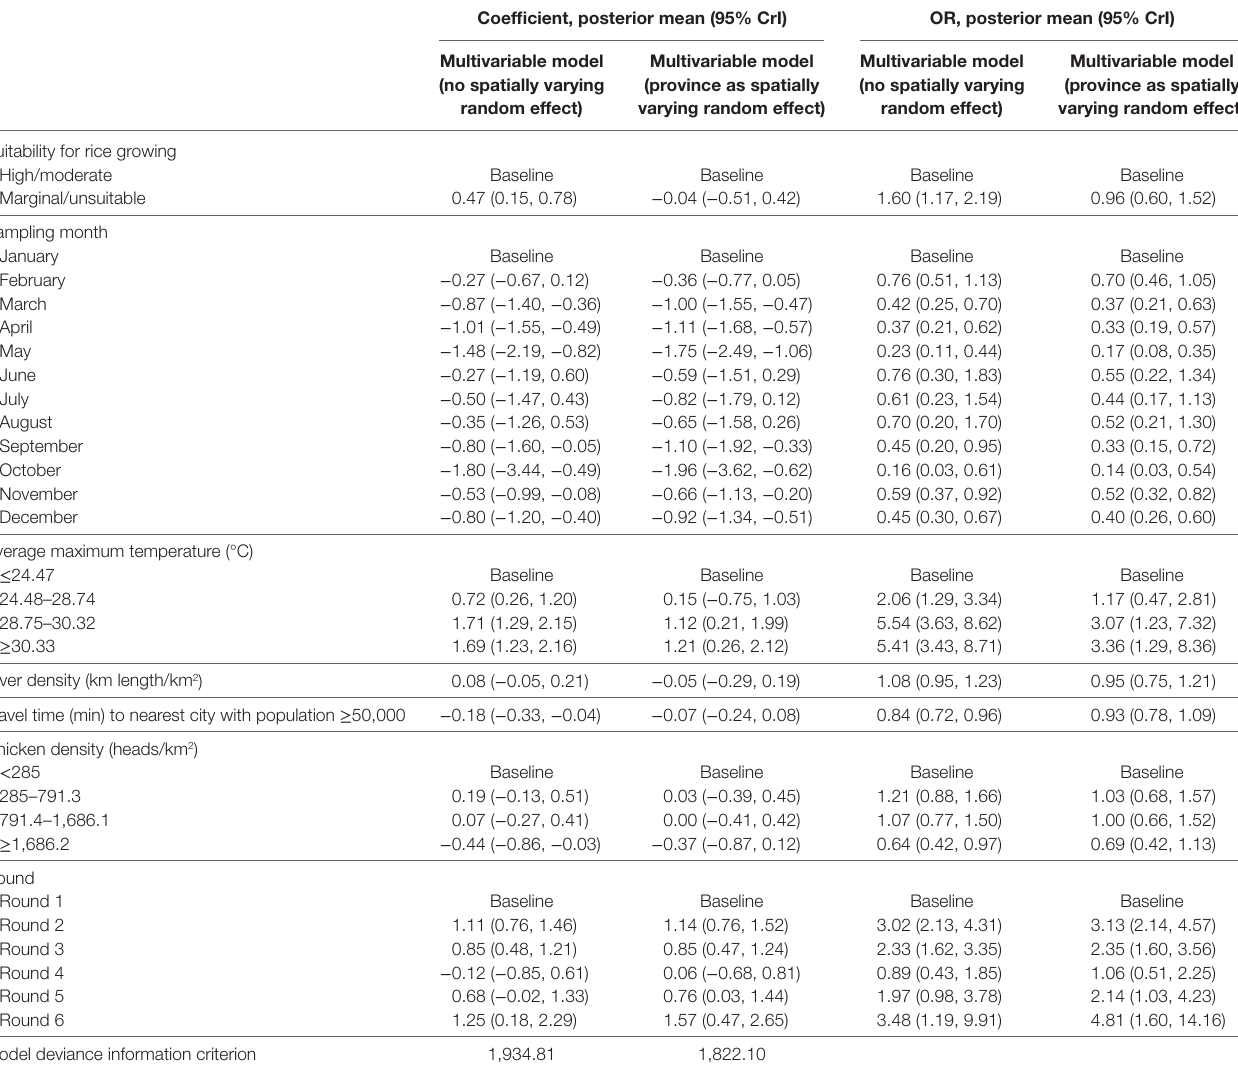
TaBle 4 | Posterior mean coefficients, odds ratios (ORs), and 95% credible intervals (CrI) of spatial and non-spatial conditional autoregressive models of market days positive for highly pathogenic avian influenza H5N1 virus (Vietnam,